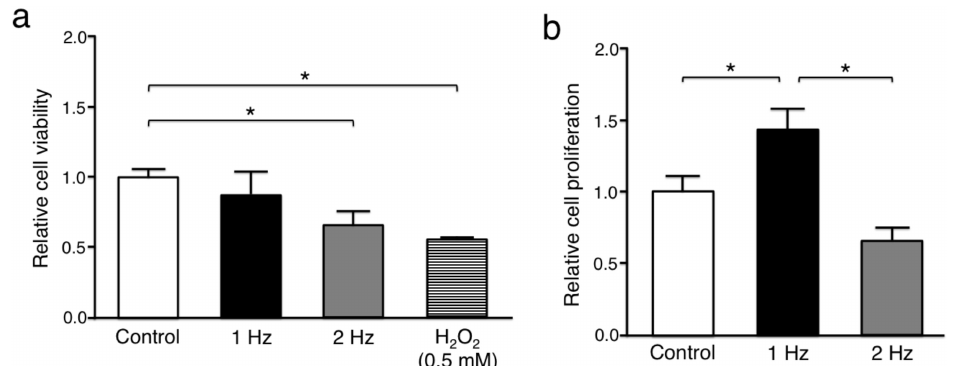
Figure 2. Comparison of cell viability and proliferation at di ff erent tensile frequencies. Comparison of cell viability among the three groups: tenocytes cultured without stretching (control), with stretching at 1 Hz, and with stretching at 2 Hz ( a ). 5% stretch was applied for 3 h. The positive control was settled by using 0.5 mM hydrogen peroxide. Comparison of cell proliferation among the three groups ( b ). The value of control was set to 1 ( n = 5; mean + SEM). * p < 0.05 indicates significance. SEM, standard error of the mean; H 2 O 2 , hydrogen